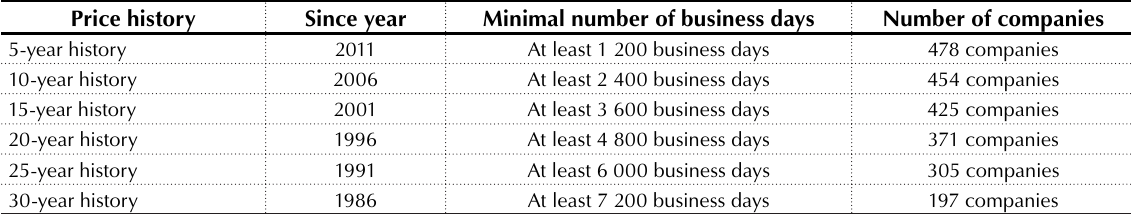
Table 1. Criteria for classification of companies into different price